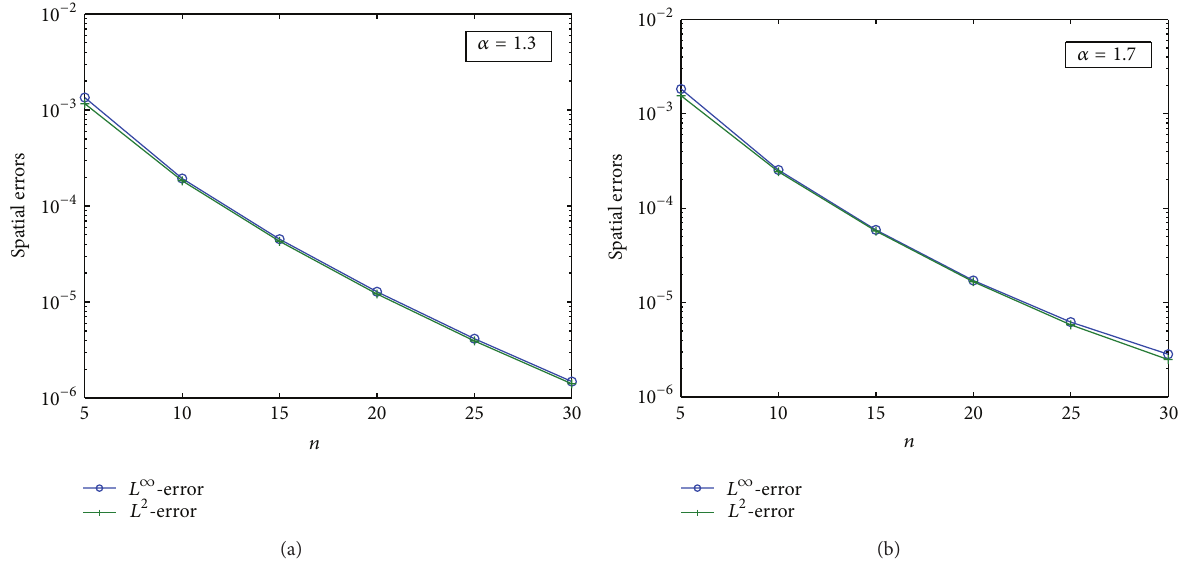
Figure 5: Spatial errors in the 𝐿 ∞ and 𝐿 2 norms versus 𝑛 for several 𝛼 .